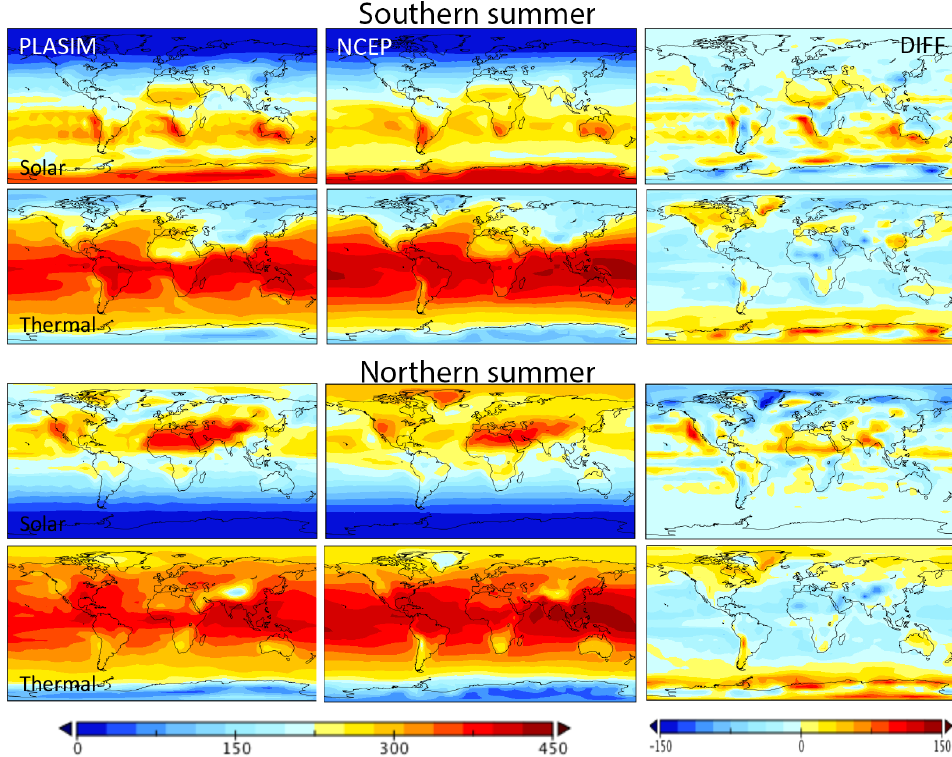
Figure 4. Seasonal incoming surface solar and thermal radiation (Wm − 2 ) . Left: PLASIM–GENIE 50-year averages; centre: long-term